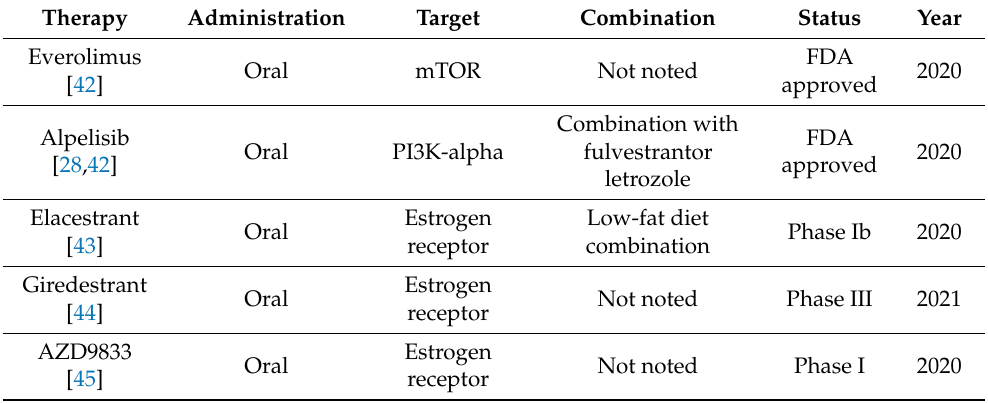
Table 1. Selected Oral Selective Estrogen Receptor Degraders or Other Inhibitors in Clinical